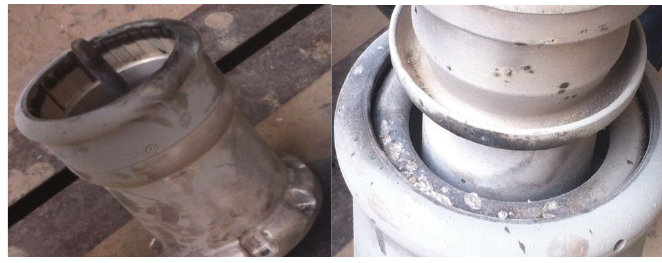
Table 6. Test results of SF 6 gas composition of the 550 kV circuit breaker. Figure 6. Contact photos of the test circuit breaker. Figure 6. Contact photos of the test circuit breaker.